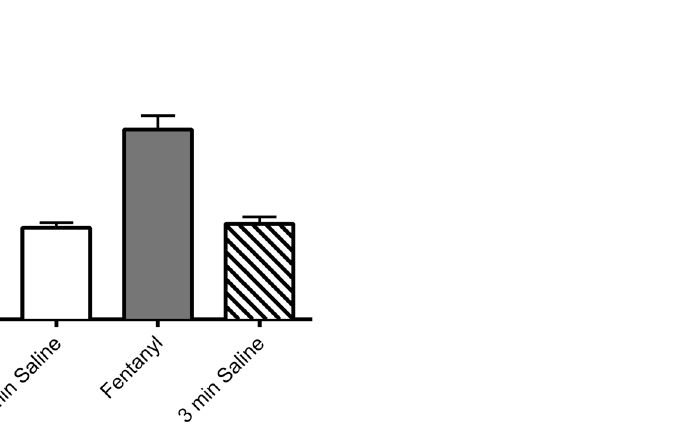
Fig. 3. Analysis of GRK/PKC and JNK inhibition on morphine and fentanyl antinociception. Rats were injected with the GRK/PKC inhibitor Ro 32-0432 (400 ng/0.4 m l), the JNK inhibitor SP600125 (100 ng/0.4 m L), or the appropriate vehicle into the ventrolateral PAG 20 min before microinjection of cumulative doses of morphine or fentanyl (N 5 7–11/condition). Morphine or fentanyl administration produced a dose dependent increase in hot plate (HP) latency. Microinjection of Ro 32-0432 into the ventrolateral PAG enhanced the antinociceptive effect of morphine (A) as indicated by a leftward shift in the morphine dose-response curve, but had no effect on fentanyl antinociception (B). Neither morphine (C) nor fentanyl (D) antinociception were altered by microinjection of SP600125 into the ventrolateral PAG.